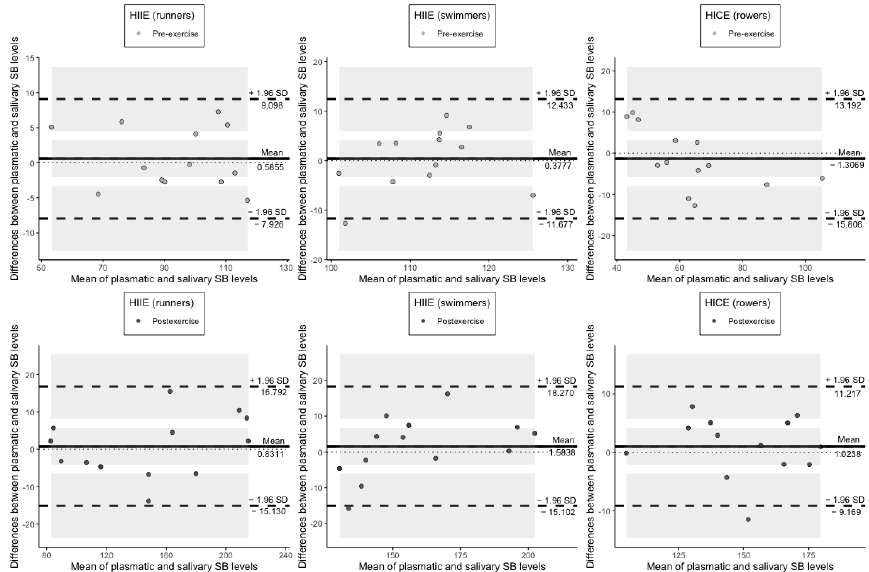
Figure 5. Plots of difference between the measurements of SB levels in plasma and saliva vs. the mean of the measurement. The bias (mean difference) is represented by a solid line parallel to the X axis. The limits of agreement are represented by the dashed lines parallel to the X axis at − 1.96 and +1.96 SD. Shaded areas present confidence interval limits for mean and agreement limits. SB: Schiff bases; HIIE: high-intensity interval exercise; HICE: high-intensity continuous exercise; SD: standard deviation.